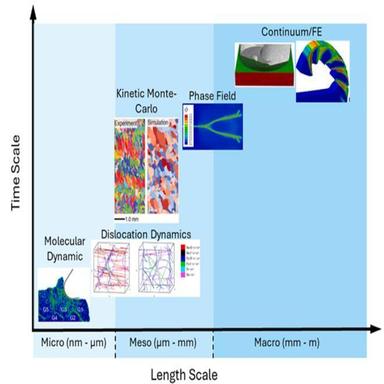
Modelling strategies for capturing materials response at various length/time scales.